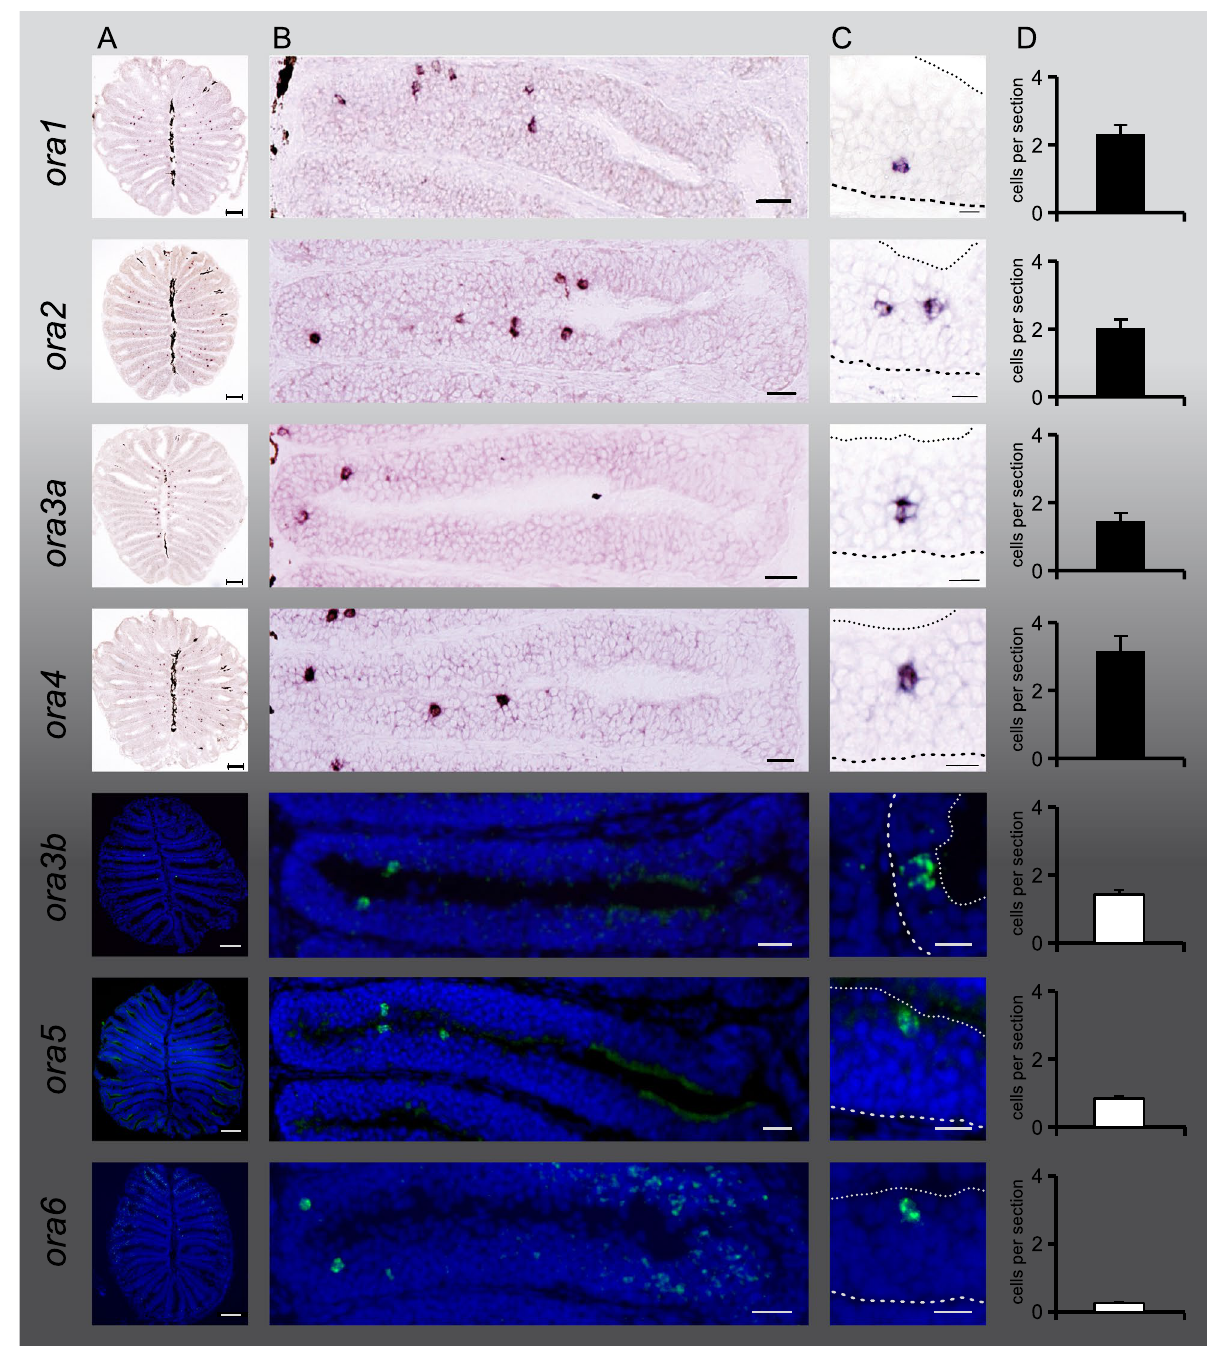
Figure 1. Expression of all seven ora genes in sparsely distributed cells in the olfactory epithelium. Horizontal sections of adult zebrafish olfactory epithelia were hybridized with probes for all seven ora genes, as indicated. Chromogenic detection by NBT/BCIP for ora1, ora2, ora3a and ora4 , fluorigenic detection with TSA for ora3b, ora5 , and ora6 . Column ( A ) shows representative complete sections labeled with the respective probes. Column ( B ), higher magnifications of a single lamella from different sections. All panels have the same orientation, center (median raphe) to the left and periphery to the right. Note that for better visualization sections with above average frequency were selected, thus values are higher than the average values shown in column ( D ). Column ( C ), higher magnification shows positions of single cells within the lamella. Coarse dashed lines depict the border to the basal lamina and fine dashed lines depict the apical border to the lumen, cf. Fig. 2. ( A ) Scale bars correspond to 100 µm, ( B ) scale bars 20 µm (30 µm for ORA1), ( C ) scale bars 10 μm. Column ( D ), bar graphs show number of labeled cells per section for each ora gene (mean +/− SEM, for number of sections analysed see SI Fig.